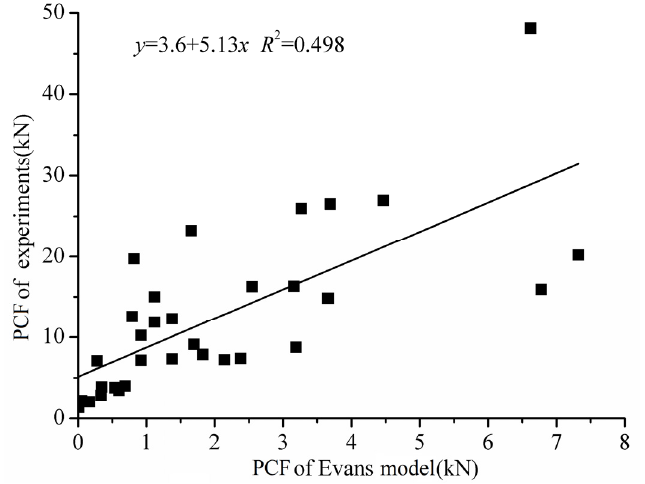
Figure 9: The relationship between the PCF of Evans model and